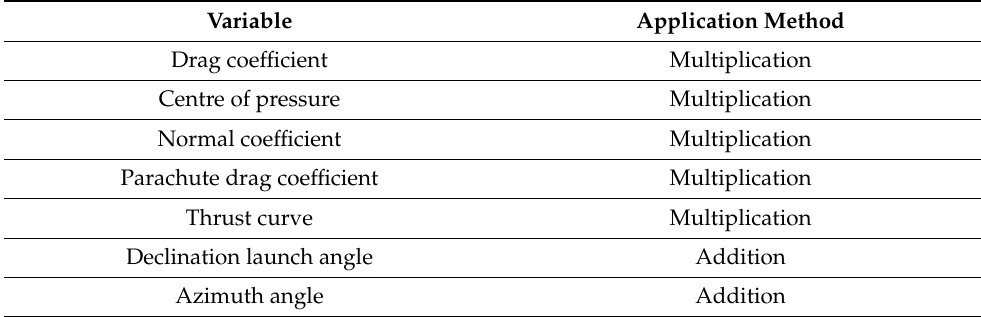
Table 3. Monte Carlo probability distributions application